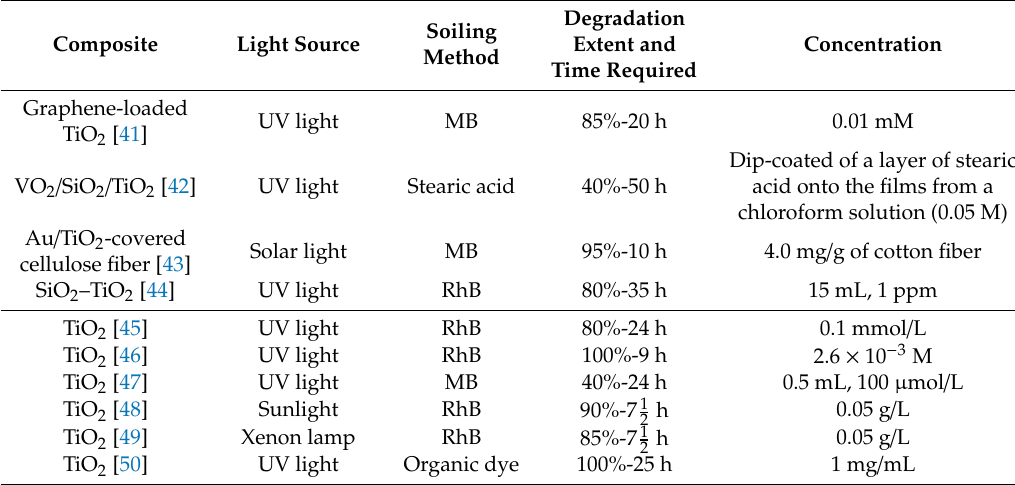
Table 3. Self-cleaning performance of di ff erent coated